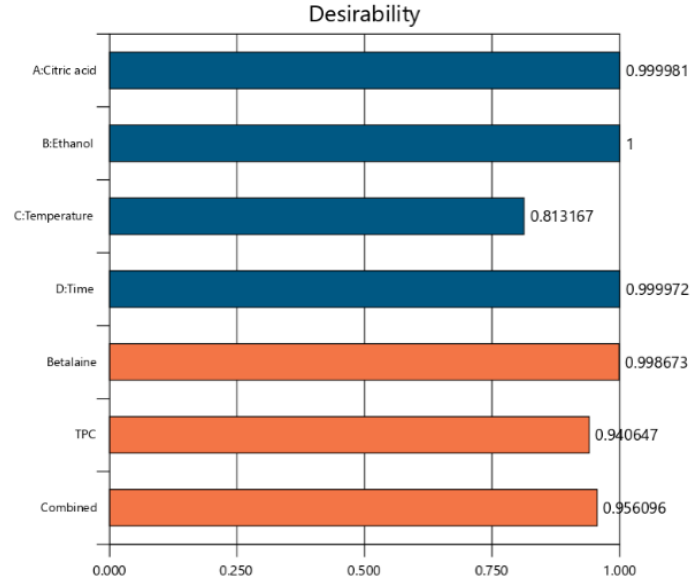
Figure 4. Desirability plot of process parameters and responses.